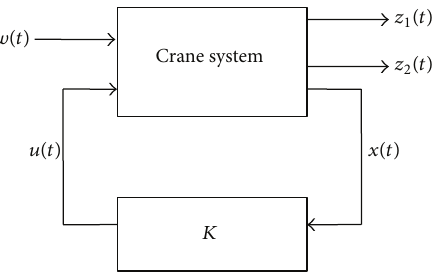
Figure 4: Block diagram of designed state-feedback control